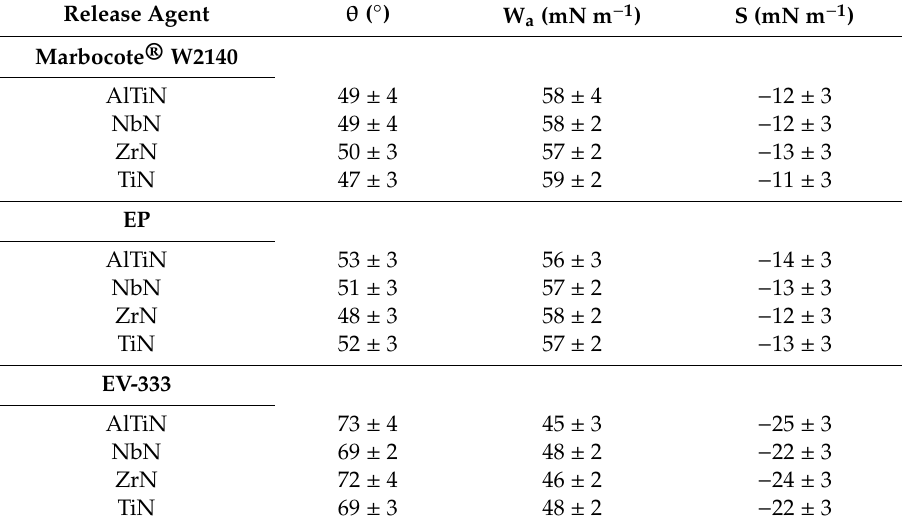
Table 4. Contact angles, work of adhesion (W a ) and spreading coe ffi cient (S) for commercial molding release agents associated with the cleaned PVD